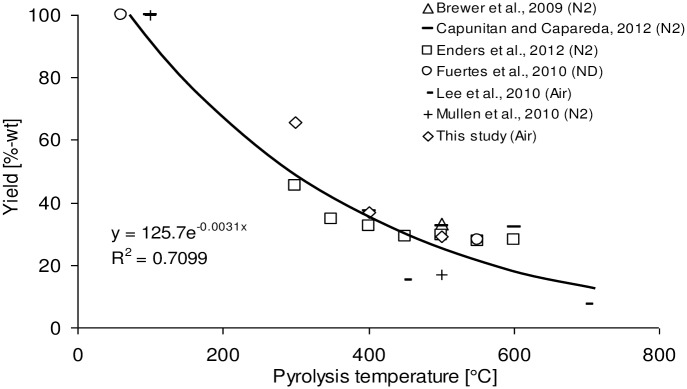
Effect of pyrolysis temperature on biochar yield from corn stover produced at different heating rates, holding times, particle sizes, reactor atmosphere and type (n = 22).